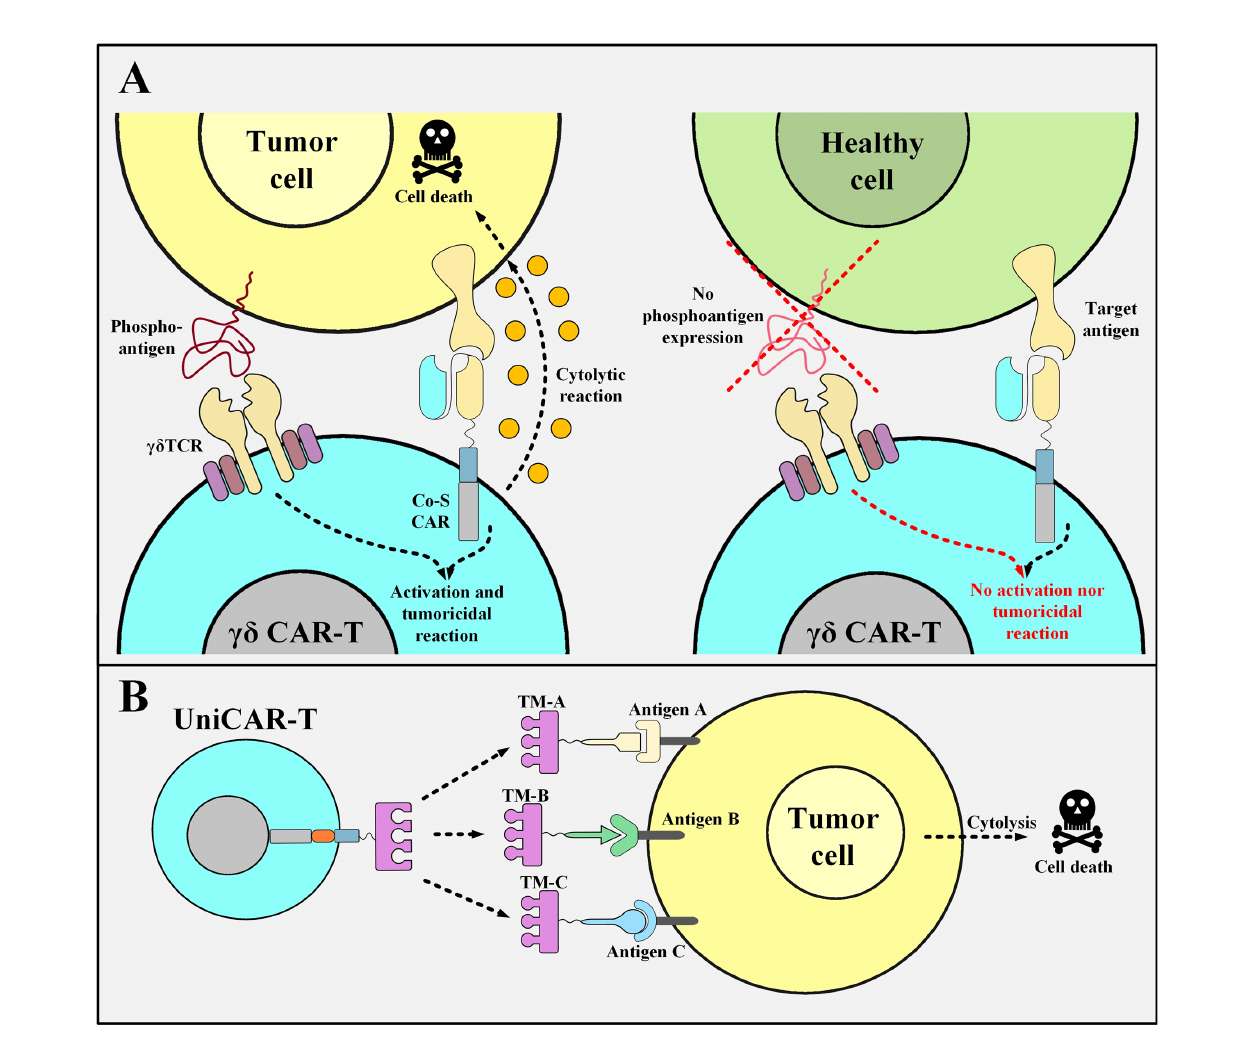
FIGURE 4 | Co-stimulation-only gd CAR T Cells and UniCAR T cells and their mechanism of action. (A) The mechanism of action of gd CAR T cells with “ co- stimulation-only ” CARs and “ V g 9V d 2 TCRs ” . The tumoricidal activity of gd CAR T cells will be in action when the CD3 z activation and co-stimulation signals are provided. The activation signal is mediated through the V g 9V d 2 TCR of these CAR T cells only when they encounter the phosphoantigens expressed by the metabolically dysregulated tumor cells. Furthermore, the co-stimulation signal is provided once the co-stimulation-only CAR molecules recognize their speci fi c TAA. Since healthy cells do not express such phosphoantigens, gd CAR T cells will not be able to mediate cytotoxic reactions against them. (B) UniCAR T cells. UniCAR T cells can be activated and redirected towards different tumor cells based on the presence of different TMs. The clearance of the TM from the circulation simply results in the quiescence of the UniCAR T cells. Co-S CAR, co-stimulation-only CAR; TM, target module; UniCAR-T, universal chimeric antigen receptor T